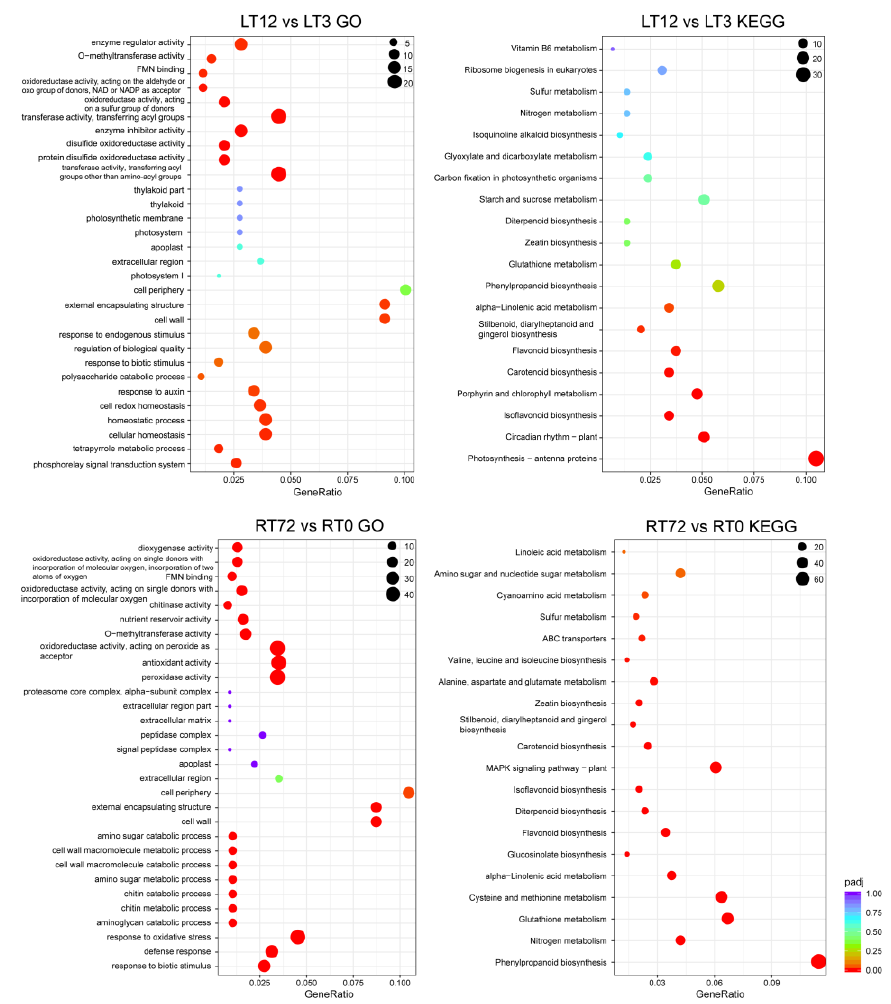
Figure 6. GO and KEGG enrichment analysis of all DEGs following CdCl 2 exposure: LT12 vs. LT3 in leaves and RT72 vs. RT0 in